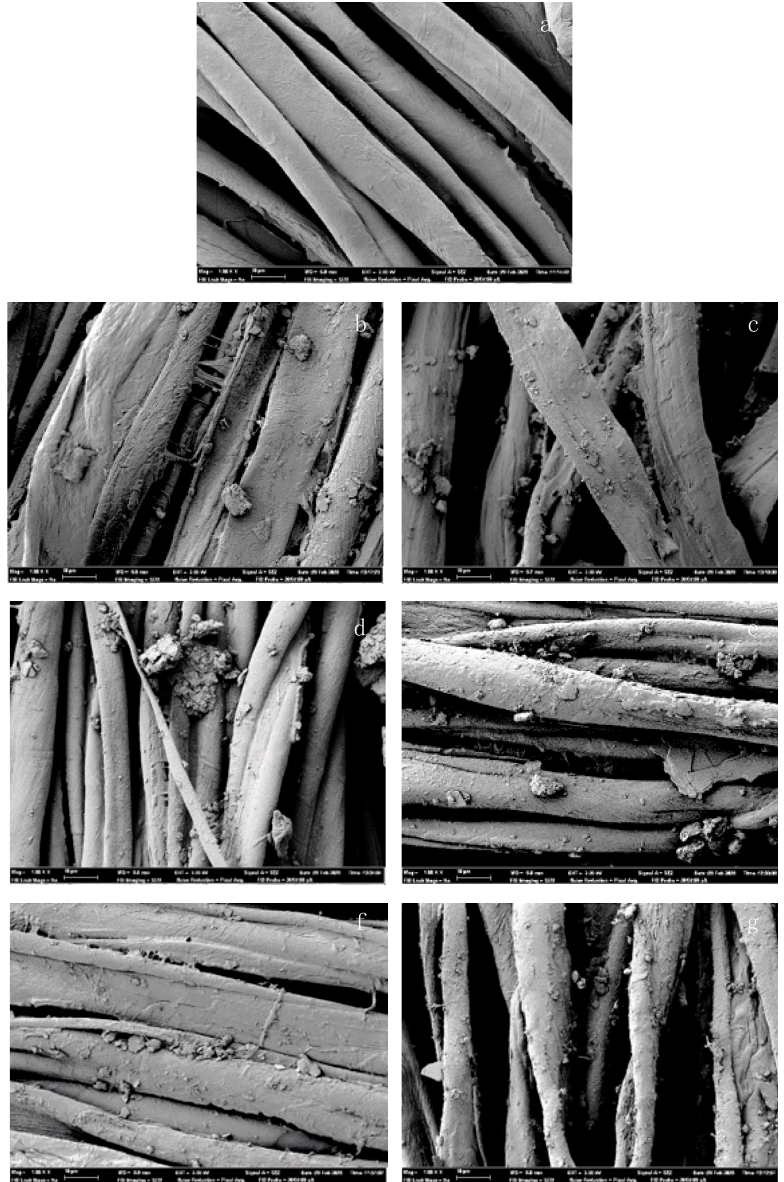
Figure 7. SEM images of samples 1000 × ( a ) untreated cotton; ( b ) 20KSF; ( c ) 20K10; ( d ) 20KSF 2.5 Ac; ( e ) 20K10 2.5 Ac; ( f ) 20KSF 2.5 PUR; ( g ) 20K10 2.5 PUR.